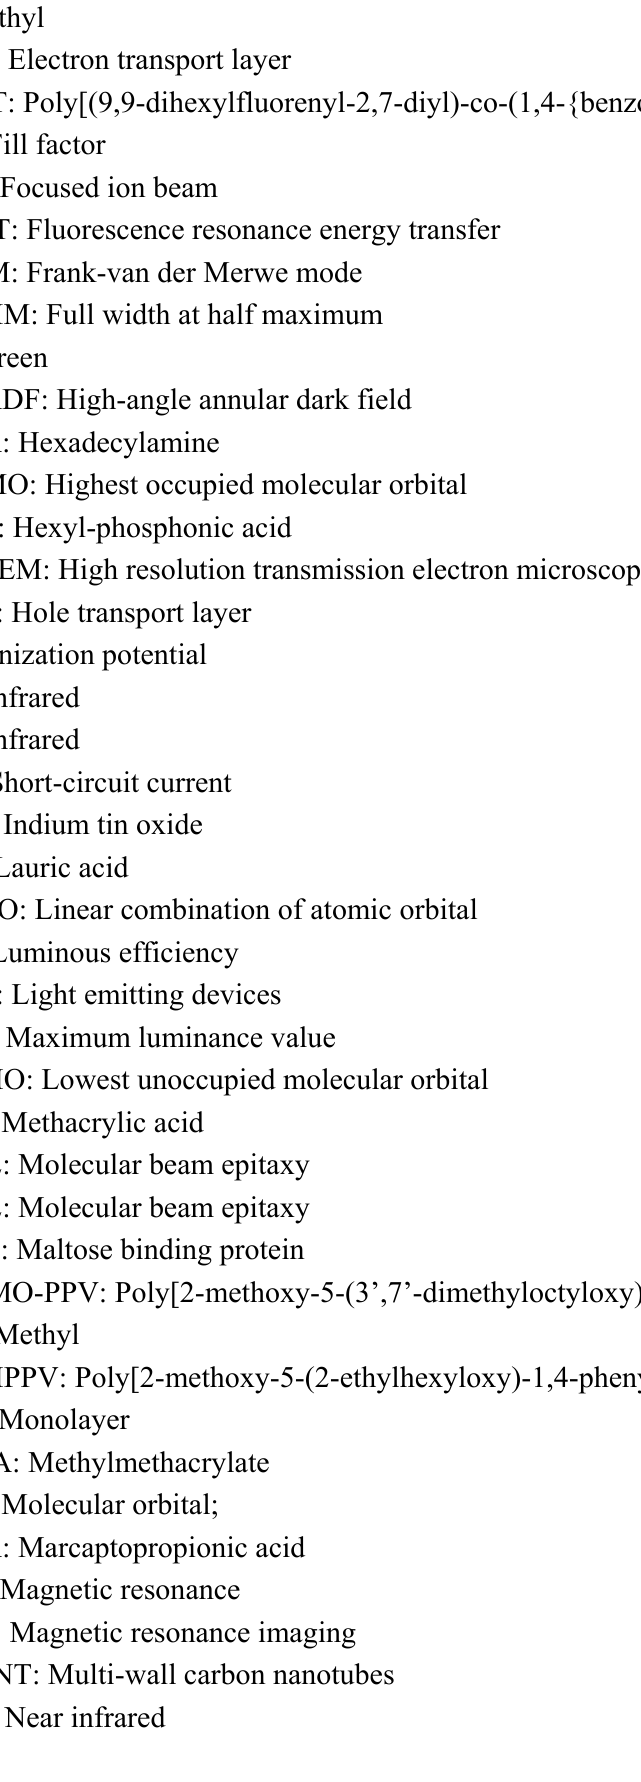
FRET: Fluorescence resonance energy transfer FvdM: Frank-van der Merwe mode G: Green HAADF: High-angle annular dark field